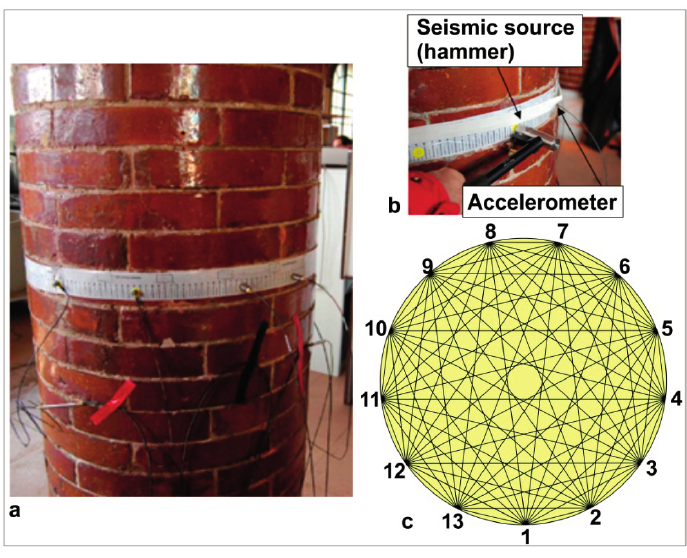
Figure 4. Seismic tomography. ( a ) Position of the accelerometers around the column; ( b ) seismic survey; ( c ) ray paths in a hypothetic homogeneous column. The numbers corresponds to the position of the receivers and the source